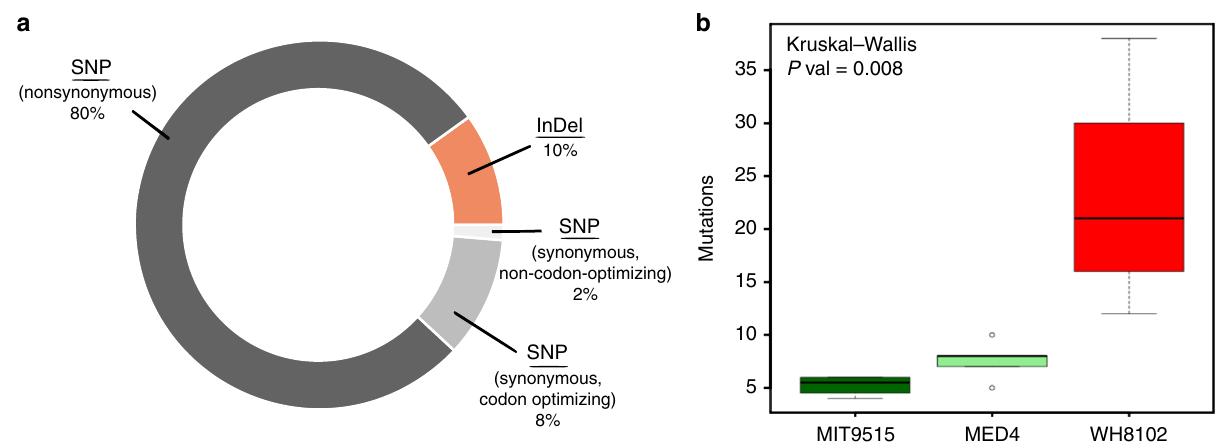
Fig. 2 Mutations in evolved S-TIM4 populations are the result of strong positive selection. a Distribution of mutation types. Circle shows the distribution of mutations by type: insertions/deletions (orange), single nucleotide polymorphisms (SNPs) (gray scale: nonsynonymous — dark gray, synonymous codon- optimizing — medium gray, synonymous nonoptimizing codon — light gray). b Distribution of the number of mutations accumulated in evolved populations, grouped according to the host they evolved in. Populations evolved in WH8102 (red, n = 4) accumulated signi fi cantly more mutations, compared to populations evolved in either MIT9515 (dark green, n = 4) or MED4 (light green, n = 5) (Kruskal – Wallis P value = 0.008). Raw data can be found